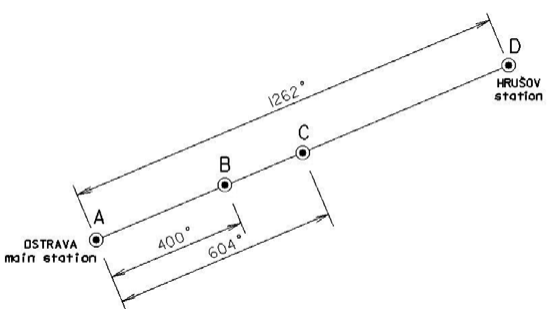
Fig. 1. Schematic representation of the main base in t Ott’s triangulation